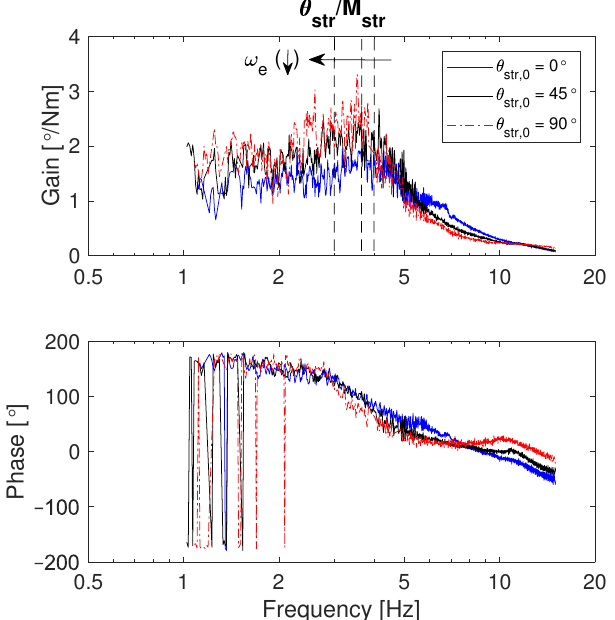
Figure 5. Measured frequency response function (FRF) for three steering angular positions (0 ◦ ,45 ◦ and 90 ◦ ) from steering torque to steering angular position.